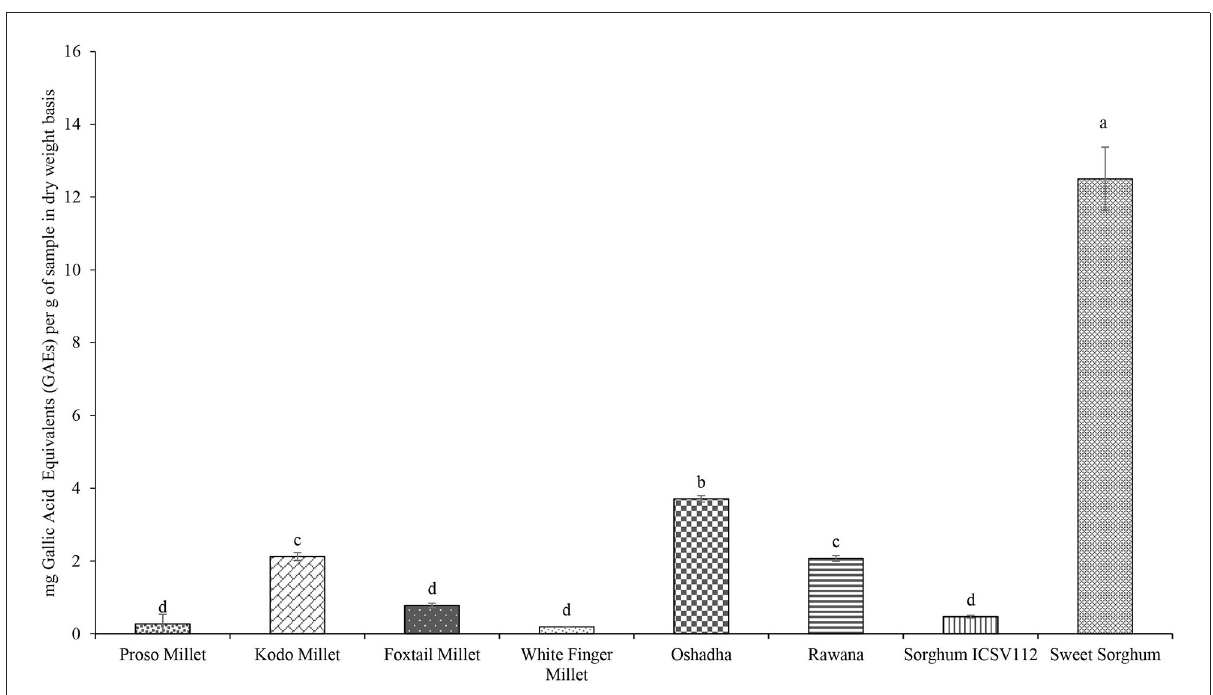
FIGURE5 Total Phenolic Content (TPC) of selected millet types and sorghum varieties. Different letters on bar graphs are significantly different at P < 0.05.